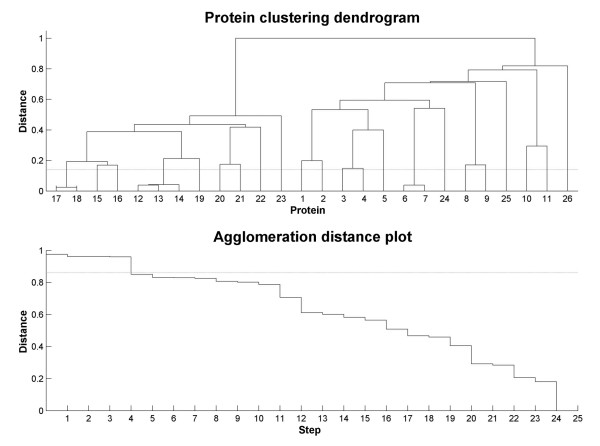
Auxiliary plots for redundancy removal in the analyzed protein family. The top dendrogram shows the clustering of proteins according to the distance (similarity percentage) between them. The bottom plot is an agglomeration distance plot of the top dendrogram. In both plots a horizontal line representing a similarity percentage of 86% that was taken as the limit over which two proteins were considered as identical. This value is the minimal value within the most pronounced step in the agglomeration distance plot. The numbers of the different proteins are the order numbers assigned in Table 2.